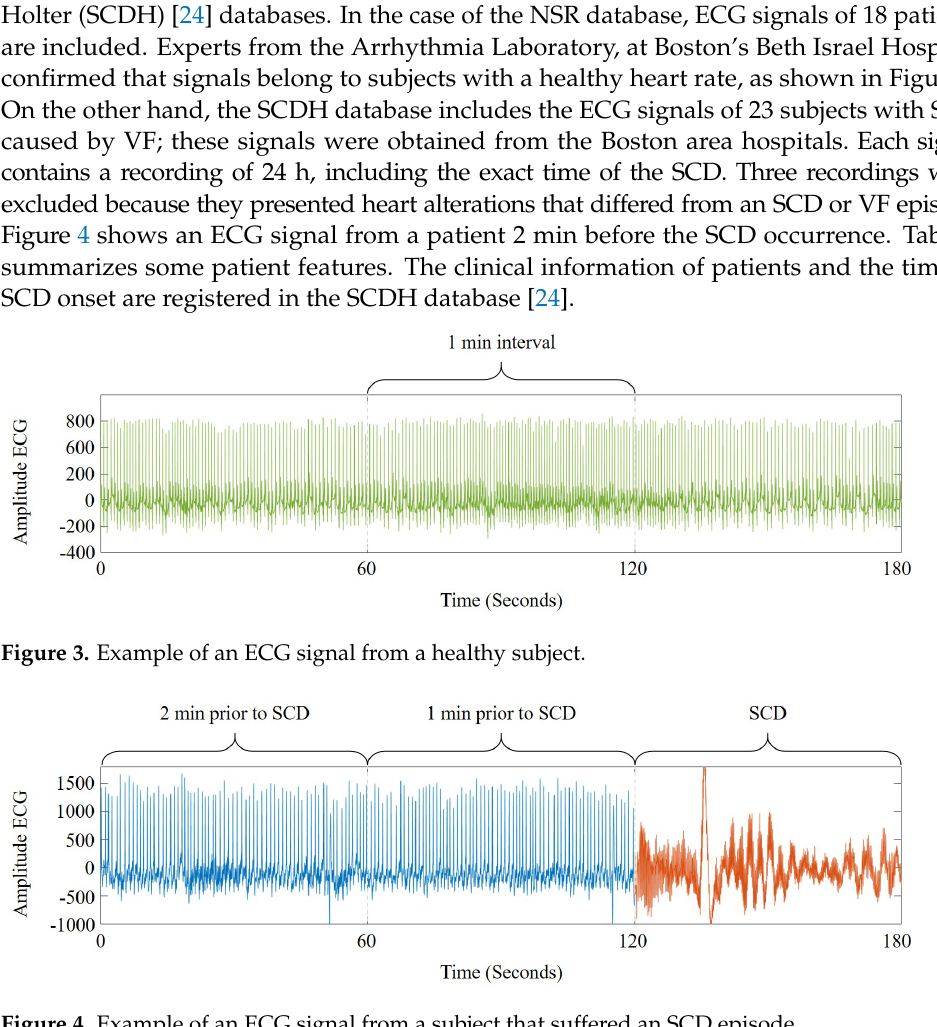
Figure 4. Example of an ECG signal from a subject that suffered an SCD